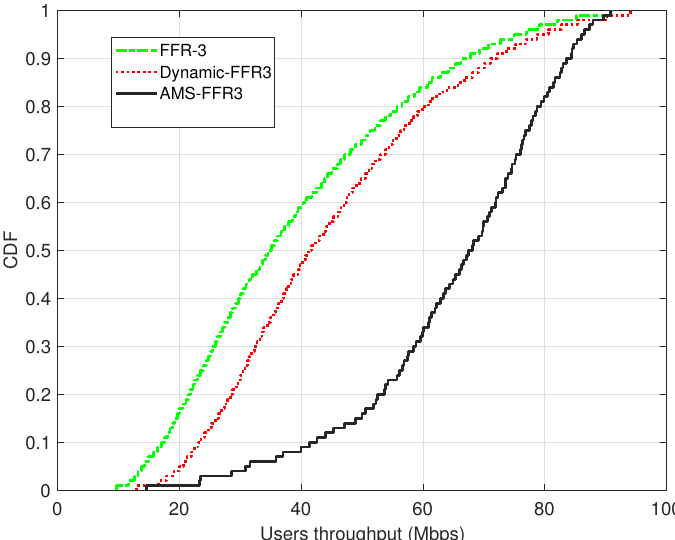
Figure 4. CDF of the users’ achievable throughput.